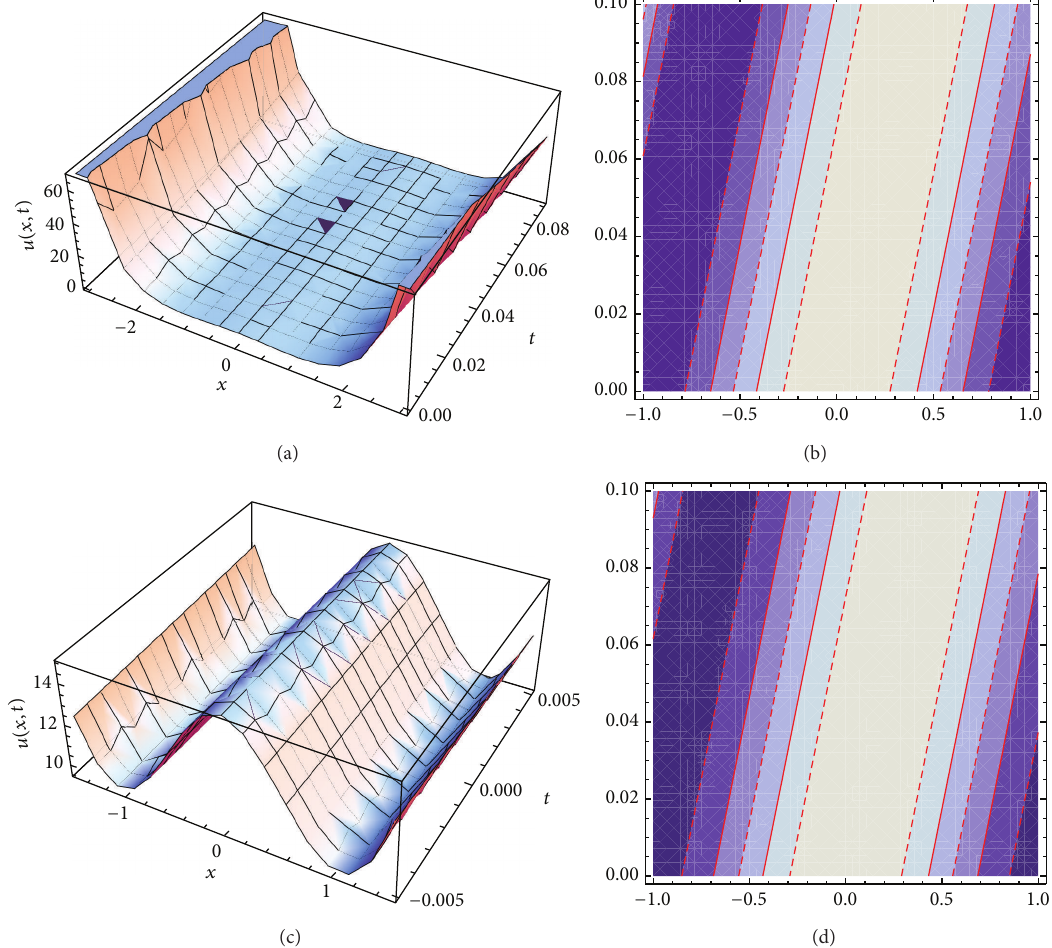
Figure 2: Travelling waves solution (20) with various different shapes are plotted: dark solitary waves in (a) and contour plot in (b). Travelling waves solution (22) with various different shapes are plotted: periodic solitary waves in (d) and contour plot in